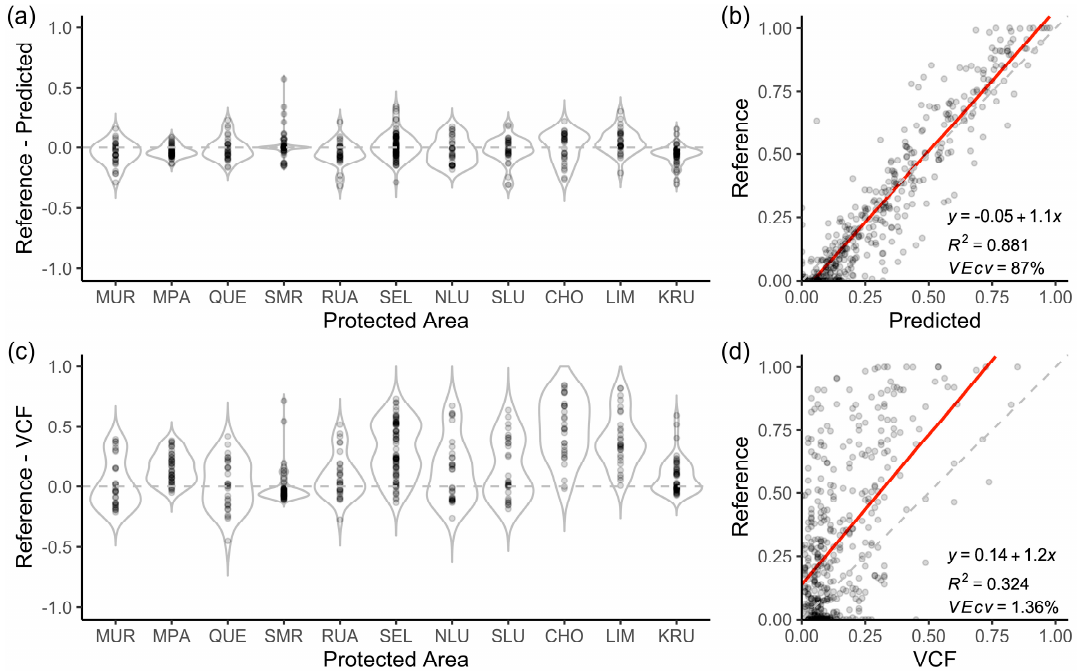
Figure 6. Our best maps and VCF compared to the testing data. Using the testing data (‘Reference’) from each PA, we plotted the errors of our best maps (“Best Overall Model” in Table 4) and the di ff erences of VCF tree cover (a and c, respectively). We then pooled the PAs and compared the reference data to our best maps (“Predicted”) and VCF (b and d, respectively). Overall, our best maps have errors that are not significantly di ff erent than zero ( a ) and a strong relationship with the reference data (R 2 = 0.881, VEcv = 87.0%) ( b ). Meanwhile, di ff erences between VCF and woody cover are significantly di ff erent than zero ( c ) and VCF has a weak relationship with woody cover (R 2 = 0.324, VEcv = 1.36%) ( d ). Both regression lines (red) are significant (p < 0.001). Individual PA maps, scatter plots and accuracy metrics (VEcv and R 2 ) are available in the Supplement, Figures